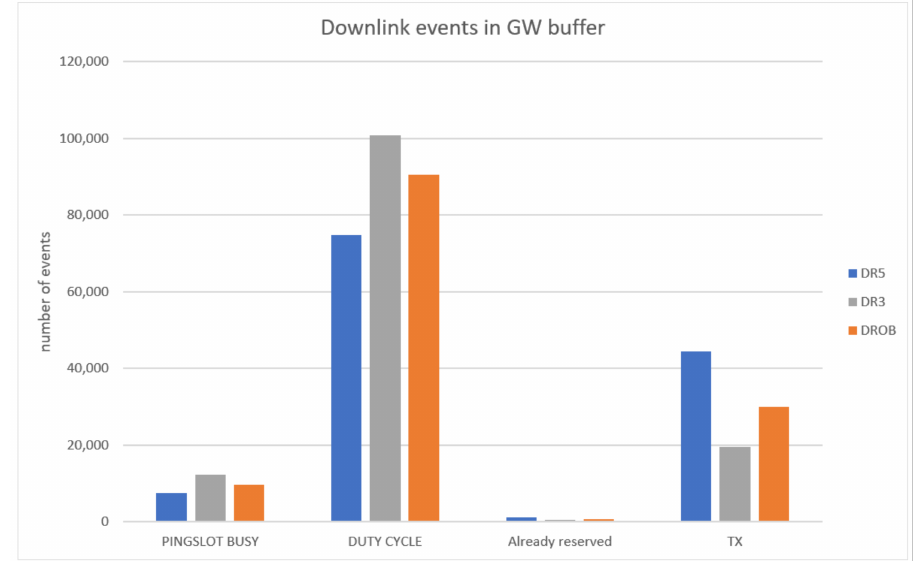
Figure 14. Downlink related events in GW output